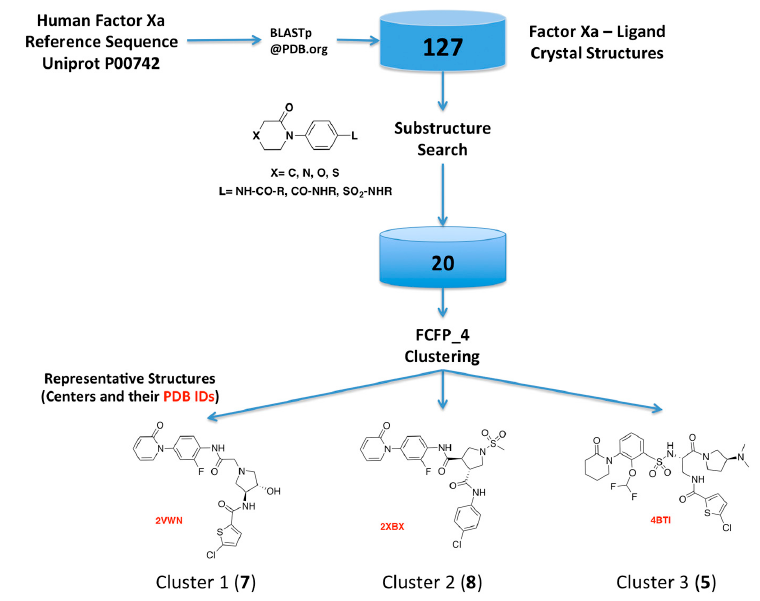
Figure 3. Schematic overview of the procedure used for selecting the FXa-ligand complexes. Table 1. Summary of crystal structures of factor Xa-ligand complexes used in this study.